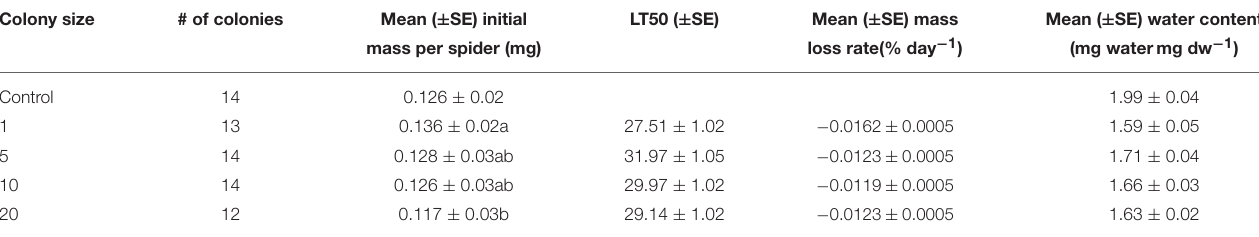
TABLE 2 | The mean spider mass ( ± SE) at onset of experiment, the number of days ( ± SE) at which 50% of the spiders had died (LT50), the mean ( ± SE) mass loss rate of spiders over 17 days and mean ( ± SE) water content for the control spiders (measured at the onset of the experiment) and the four group sizes of spiders (1, 5, 10, and 20; measured at death of the spider). Colony size